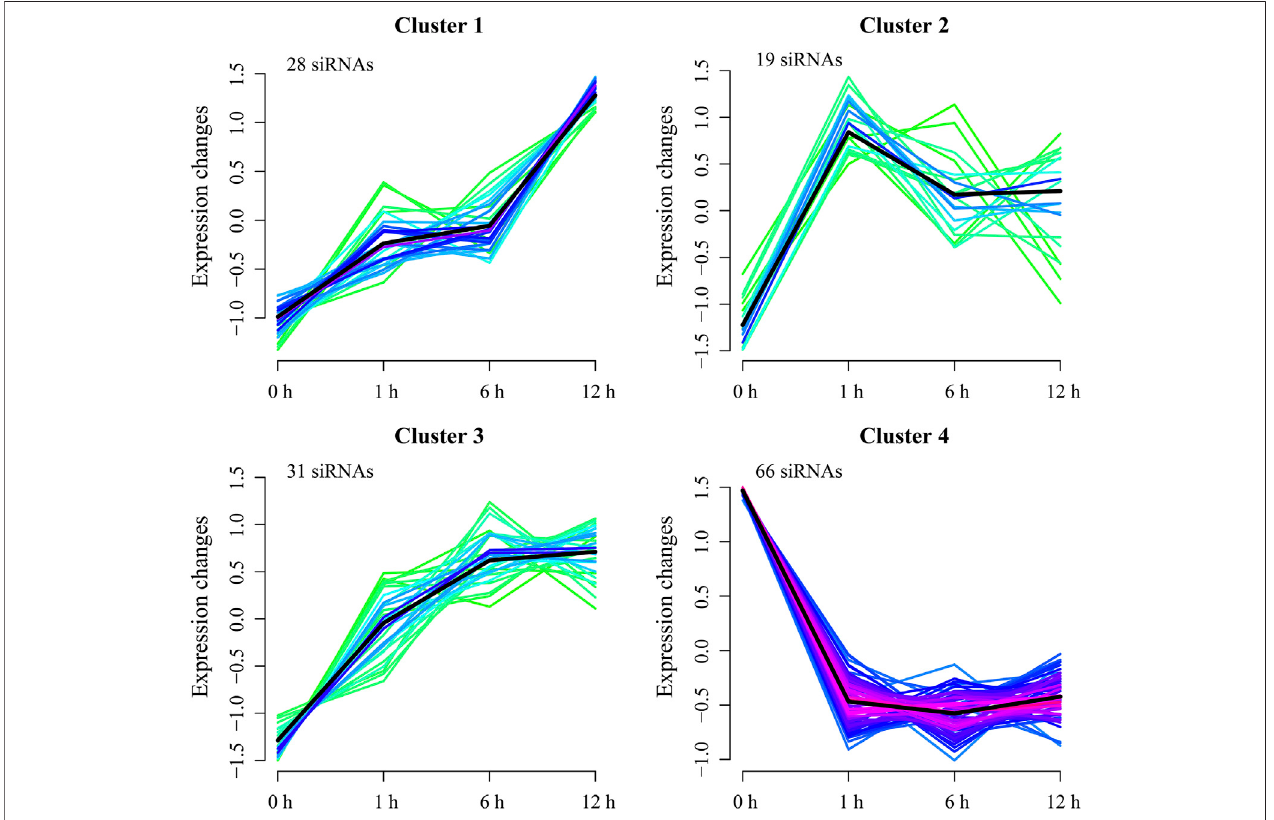
FIGURE 4 | Cluster analysis of DE-siRNAs. Lines re fl ect expression changes for each DE-siRNA at 1, 6, and 12 h. Black lines are mean changes in expression of siRNAs in each cluster.